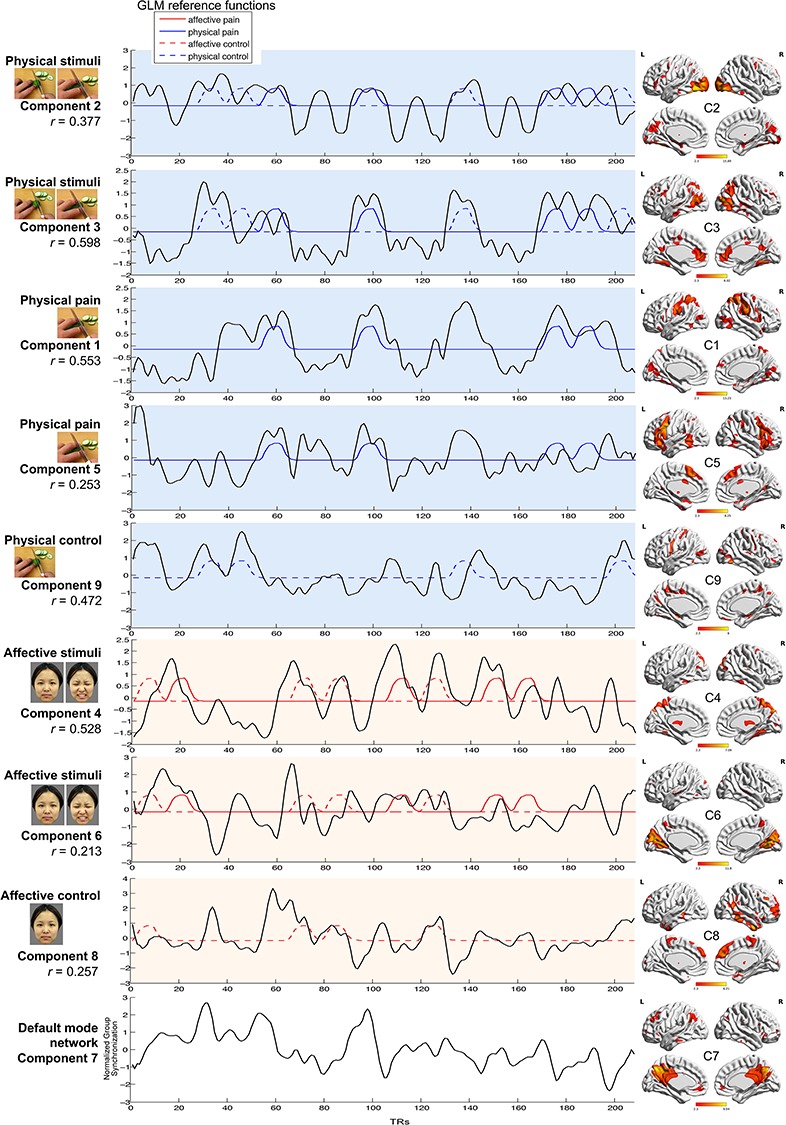
Synchronization of the nine components. (C = component; R = right; L = left). The left panel displays correlation coefficients of each component and the most associated task condition. The middle panel displays the synchronization time courses for each component and the GLM reference functions it is most associated with. The right panel shows the spatial weights for each component [visualized with BrainNet Viewer (Xia et al., 2013)].